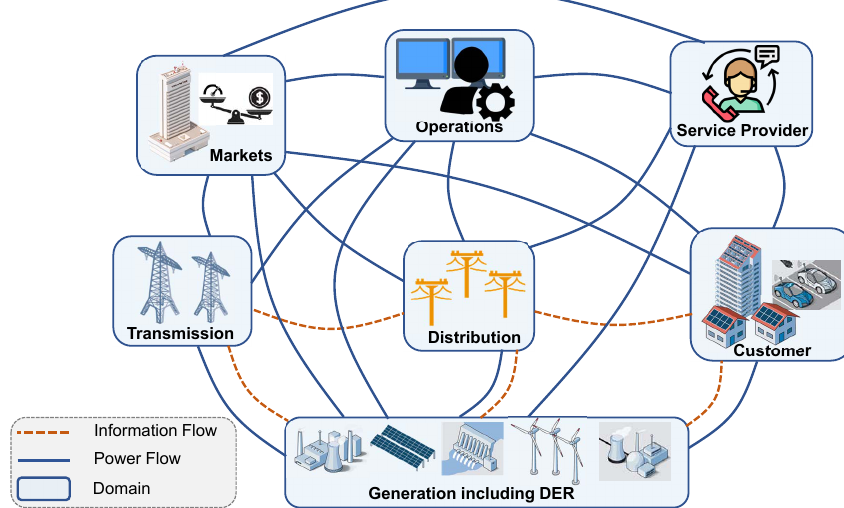
Figure 3. The conceptual model of the smart grid